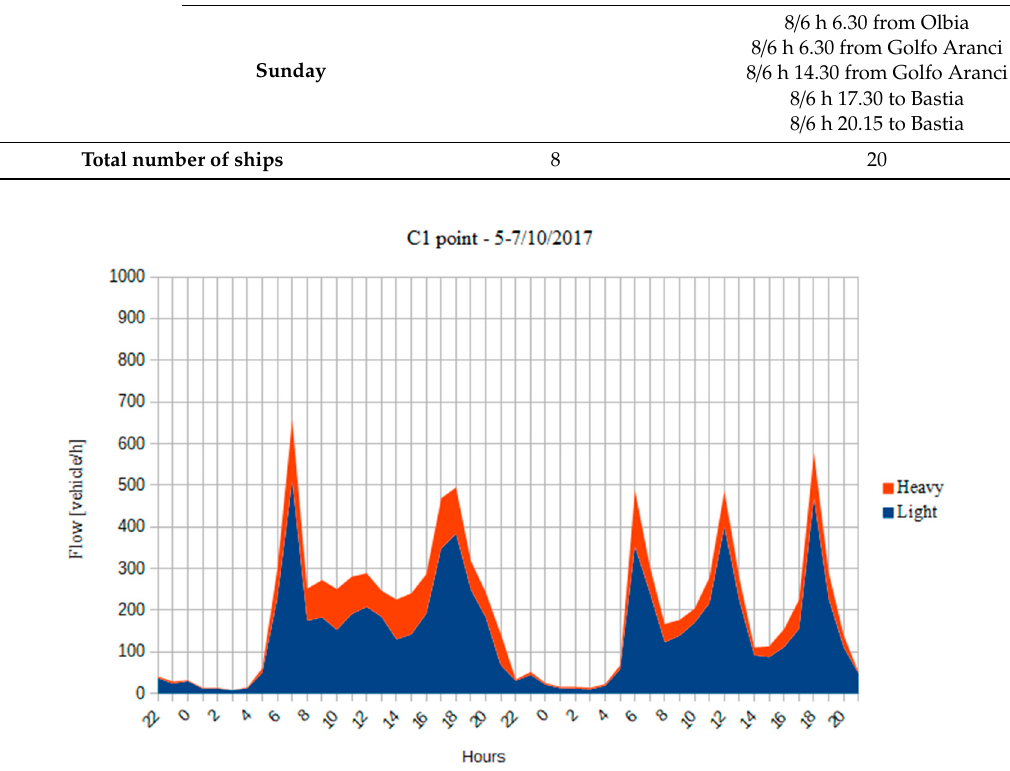
Figure 6. Vehicle flux measured in the proximity of Point C1 in October. In orange is the heavy vehicle flux, in blue is the light vehicle flux.